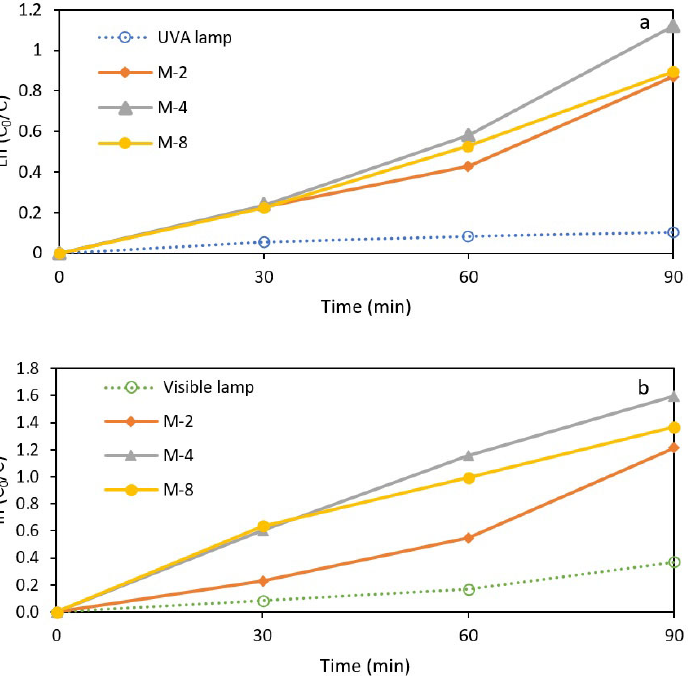
Figure 12. ( a ) Photocatalytic degradation of MB for M-2, M-4, and M-8 membranes under UVA, and ( b ) under visible light illumination.